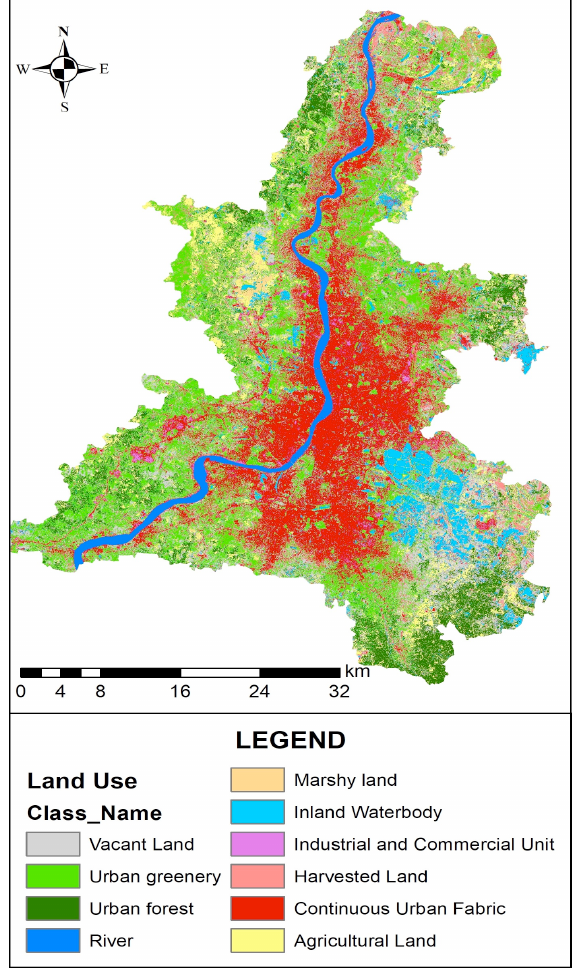
Figure 2 . Land use map of